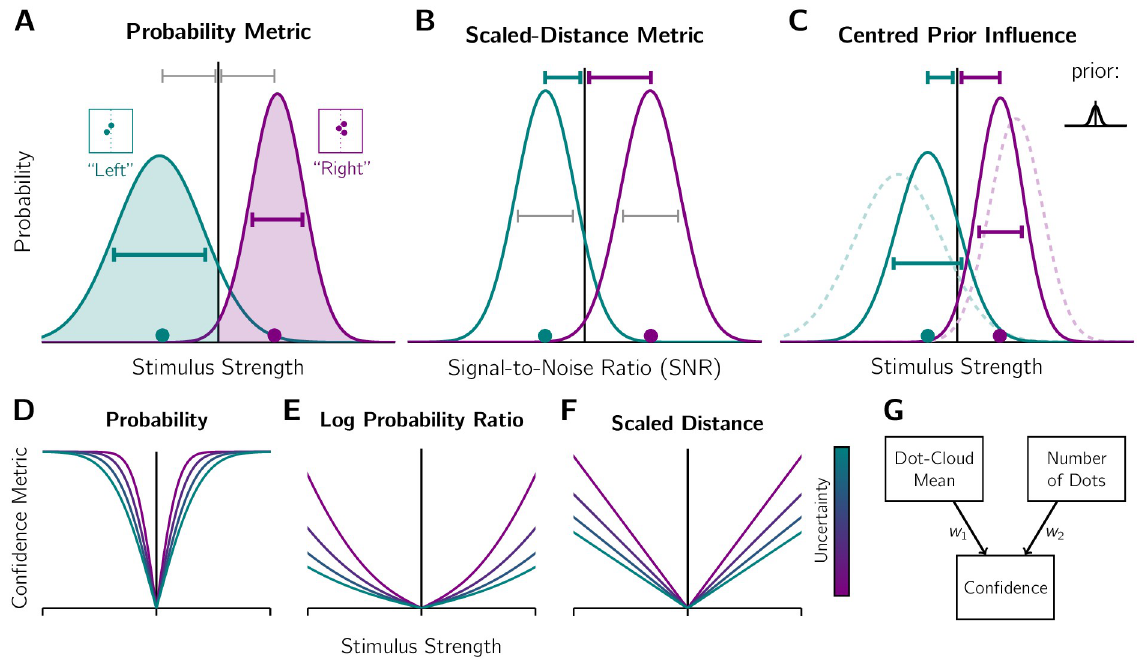
Fig 1. Sensory uncertainty and stimulus strength in the confidence computation. A-C) Extracting the confidence decision variable from the Type 1 decision process. Scenarios contrasted: dot cloud with 2 dot samples (teal; high uncertainty; see inset for stimulus) and a 3-sample dot cloud (purple; low uncertainty), with both dot-clouds’ means equidistant from the screen centre (dotted line of inset). The observer correctly identifies the lateralisation of the generating distribution’s mean, as shown by their response in quotation marks. Vertical line: decision boundary. Horizontal lines: similarities (grey) or differences (coloured) between the distributions. A) Probability metric. Curves: normalised likelihood functions of the distribution mean, given the sensory measurement (marker; the most likely measurement selected for illustrative purposes). Shaded region: probability of the judgement being correct. The shaded region is greater for the 3-dot scenario, so the observer has higher confidence in this judgement. B) Scaled-distance metric. A signal-to-noise ratio transformation is applied to the distributions in A (i.e., rescaled to units of standard deviation while the areas under the curve on either side of the Type 1 criterion are preserved). The rescaled sensory measurement in the 3-dot scenario has a greater Distance-from-Criterion (DFC) and is judged as more confident. C) Influence of a centred prior (see inset). The posterior distributions (continuous curves), computed according to Bayes’ Rule, are differentially shifted towards the centre from the likelihood function locations (dashed). The 2-dot scenario is shifted more because of its higher uncertainty. Consequently, Probability metrics and DFC metrics yield higher confidence for the 3-dot scenario. D-F) How the confidence metric is affected by stimulus strength and sensory uncertainty (low to high uncertainty represented by colours ranging from purple to teal). The greater the stimulus strength (i.e., distance of mean from centre), the larger the confidence metric. However, raw probability values asymptote at 100% confident (D), whereas the confidence decision variable is unbounded if a Log-Probability-Ratio transformation is applied to the probability of being correct (E) or an Unscaled- or Scaled-Distance metric is used (F). Sensory uncertainty affects the rate of change of the confidence metric in response to changes in stimulus strength. Note y -axes have been rescaled for illustrative purposes. G) Heuristic confidence metric computed from estimates of stimulus strength (dot-cloud mean) and sensory uncertainty (number of dots) without consideration of the Type 1 process. The observer sets the weights on these factors, w 1 and w 2